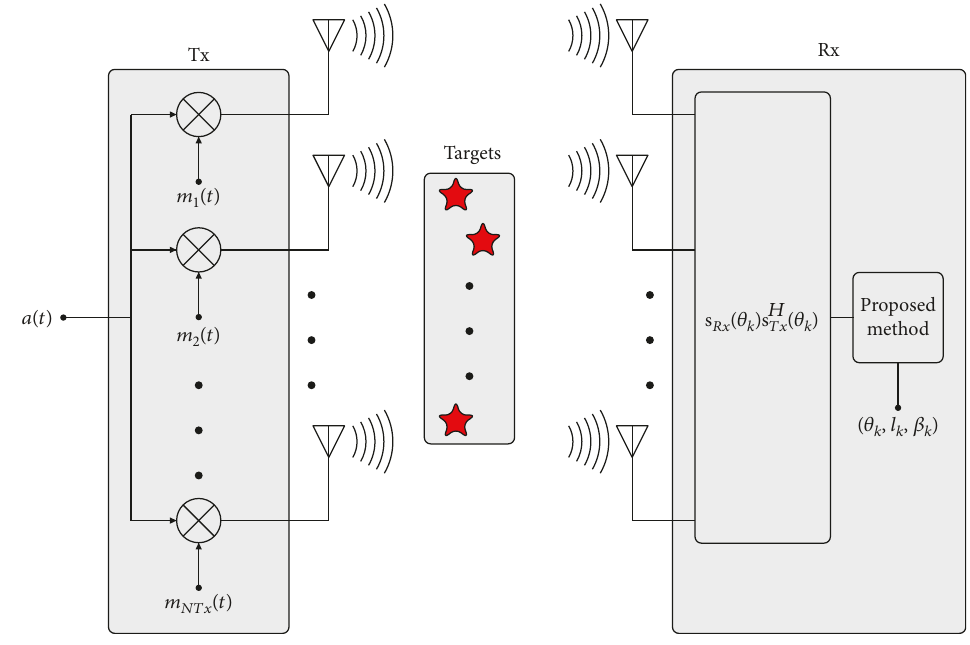
Figure 1: Monostatic radar system